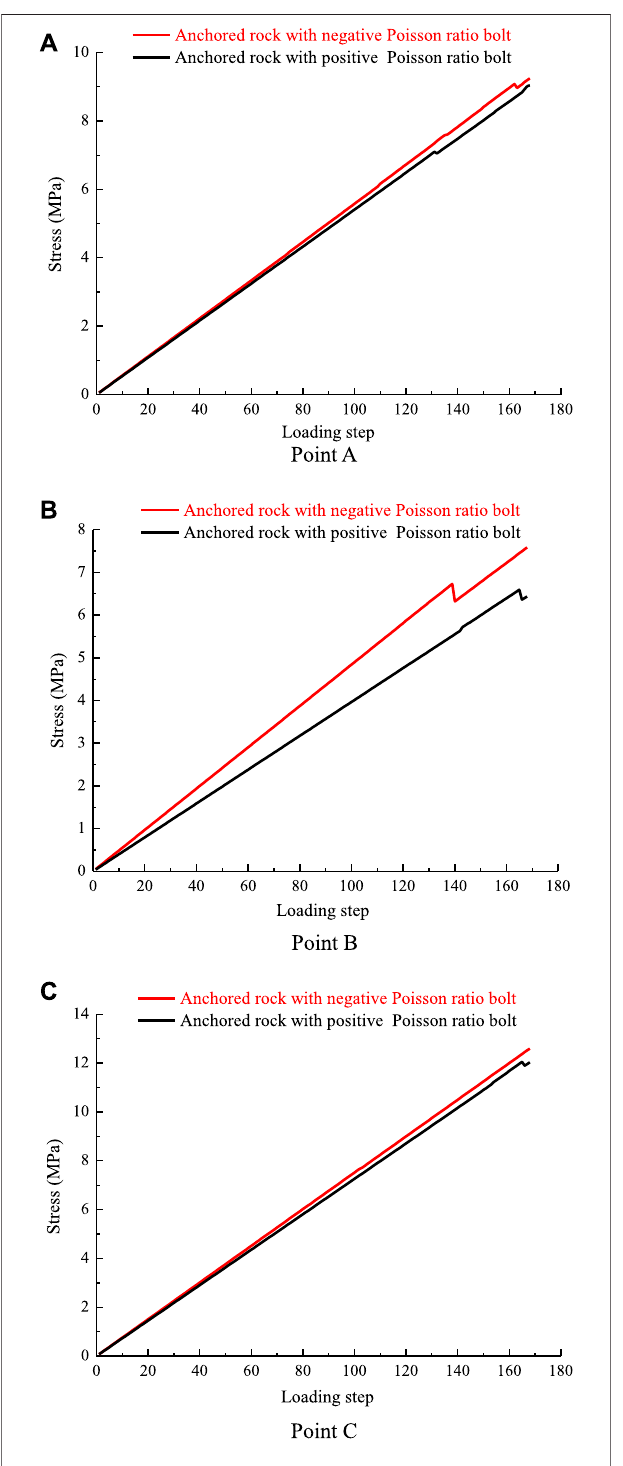
FIGURE10| StresscomparisoncurvesofpointsA,B,andCoftwokindsof anchored rock before loading step 168. (A) Point A. (B) Point B. (C) Point C.